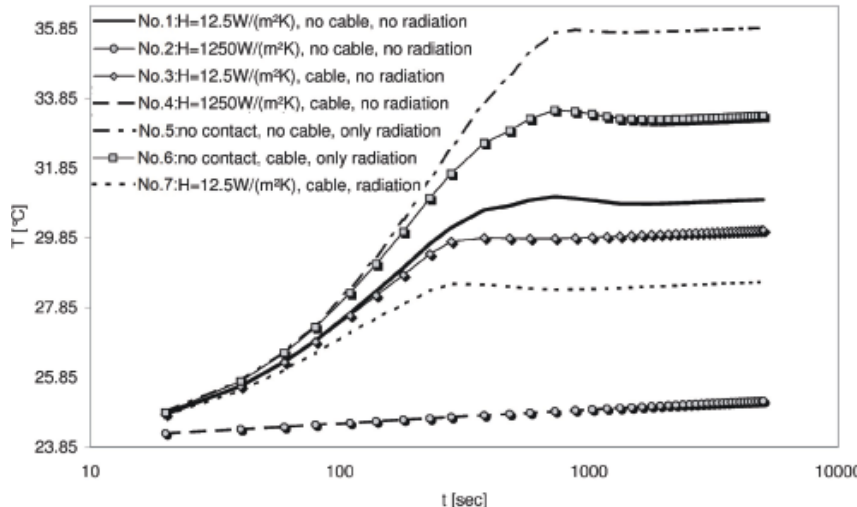
Fig. 11. Temperature response of the commercial TP02-sensor at the measurement point due to heating in a moderate conductivity sample with λ = 0 . 2Wm − 1 K − 1